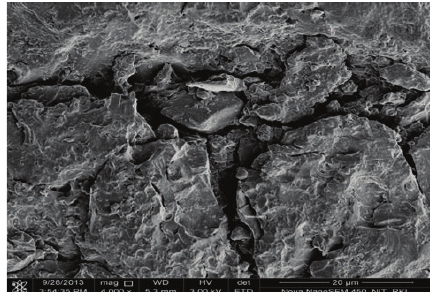
Figure 13: SEM of eroded composite surface (impact velocity 48 m/s, 15wt% filler, and impact 45 ∘